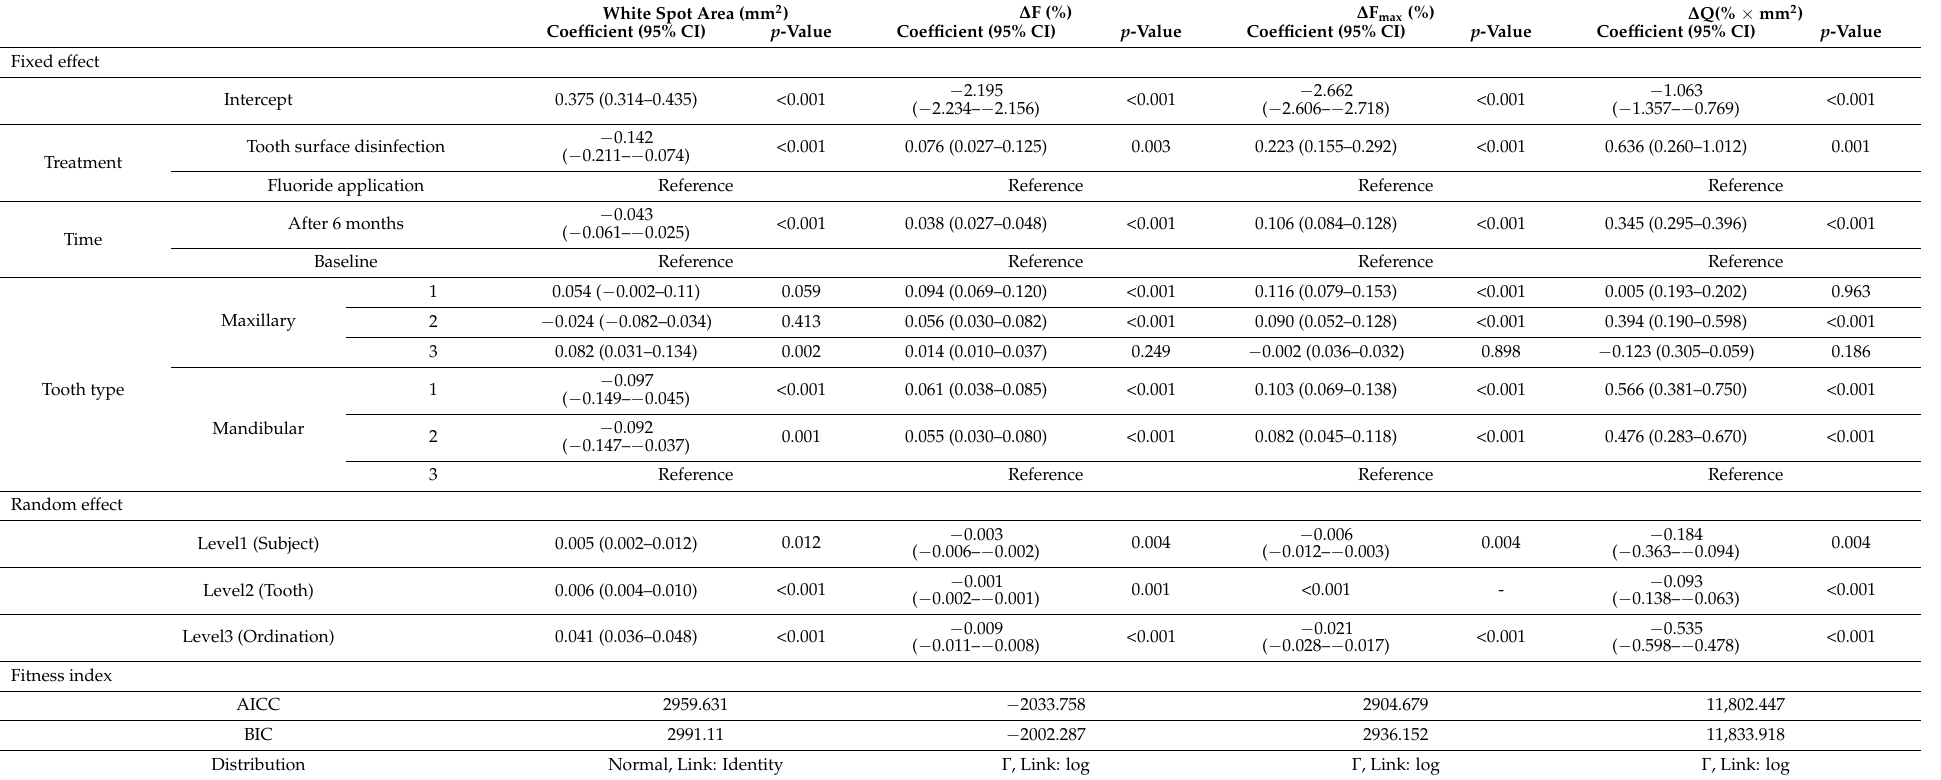
Table 1. Results of mixed effect modeling for the changes of QLF parameters before and after